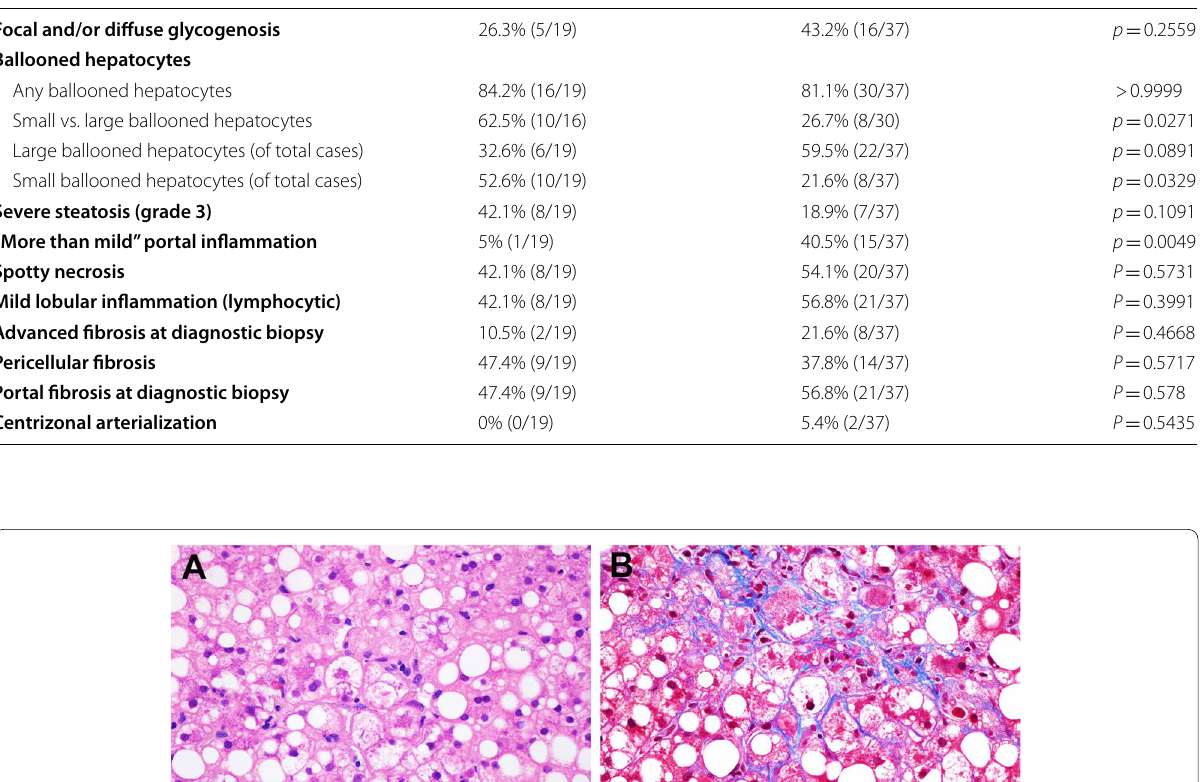
Recurrent NASH ( n 19) =